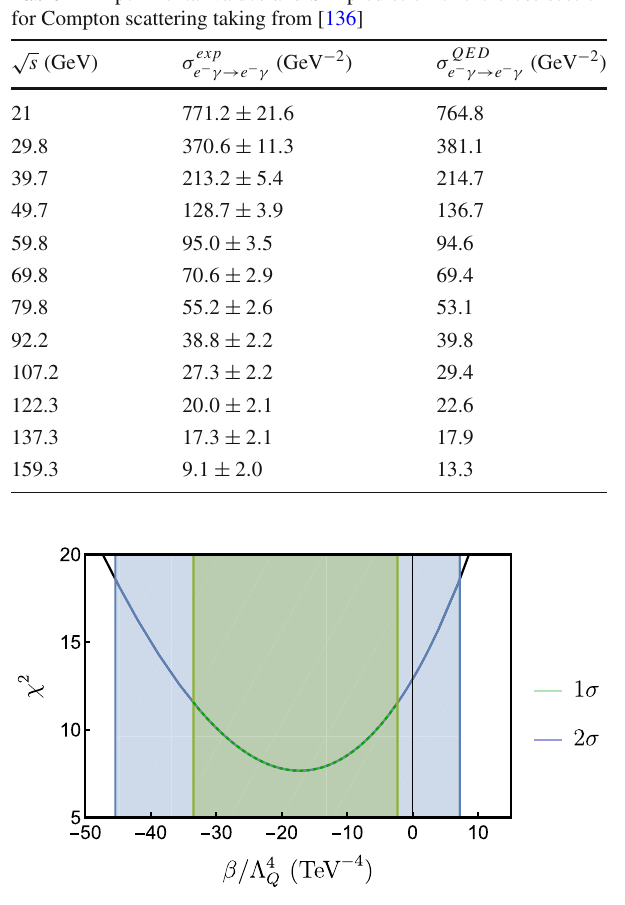
Fig. 2 Valueofthe χ 2 fordifferentvaluesof β/(cid:2) 4 bands indicate the allowed values of β/(cid:2) 4